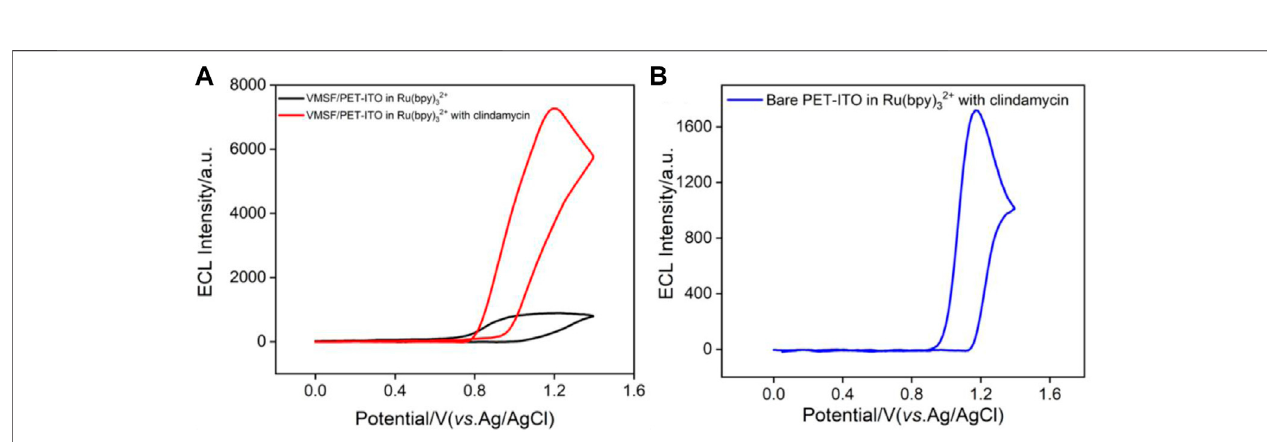
FIGURE 4 | (A) ECL signals obtained on VMSF/PET-ITO electrode in PBS containing Ru (bpy) 32+ (10 μ mol/L) before and after adding clindamycin (30 μ mol/L). (B) ECL signal obtained on bare PET-ITO in the mixture of Ru (bpy) 32+ (10 μ mol/L) and clindamycin (30 μ